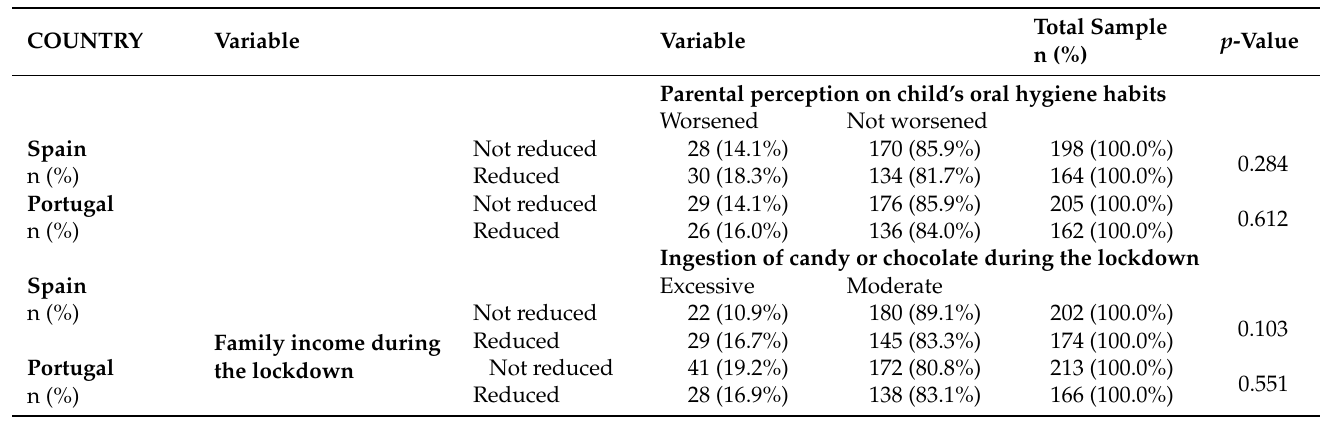
Table 4. Sociodemographic characteristics, dietary patterns, oral health behaviors and status of the participating children during the